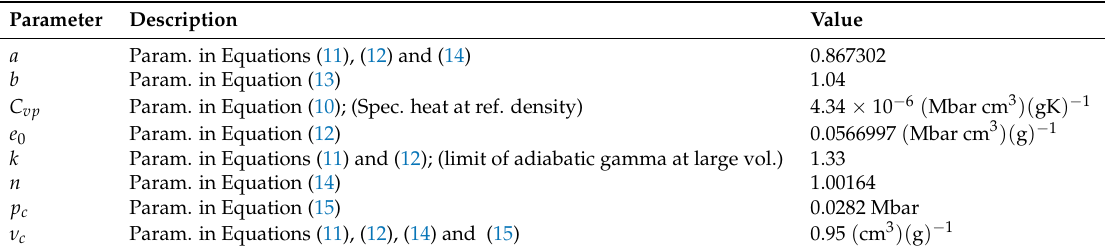
Table 3. Davis products parameter